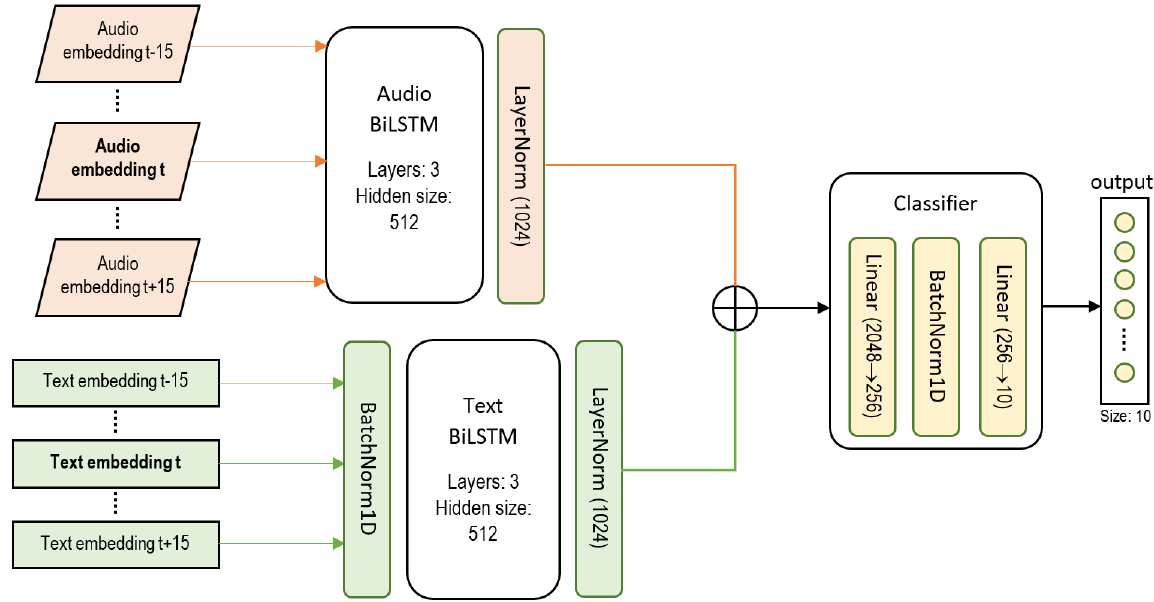
Figure 9. Diagram of our classifier